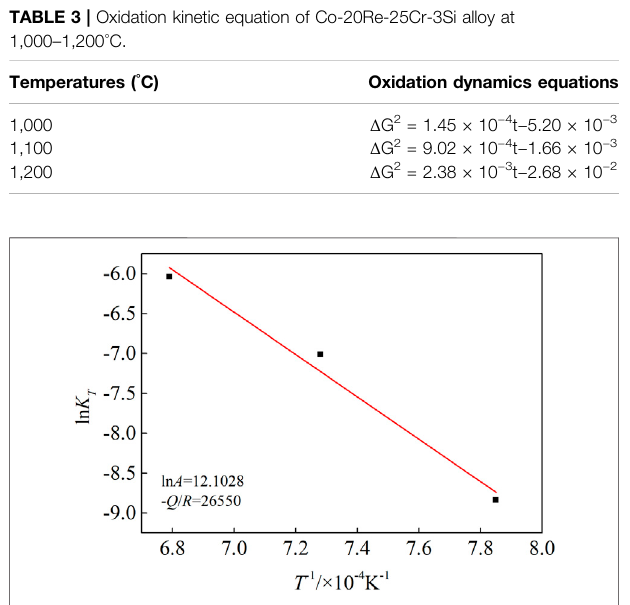
FIGURE 5 | ln K T as a function of 1/ T of Co-20Re-25Cr-3Si alloy.